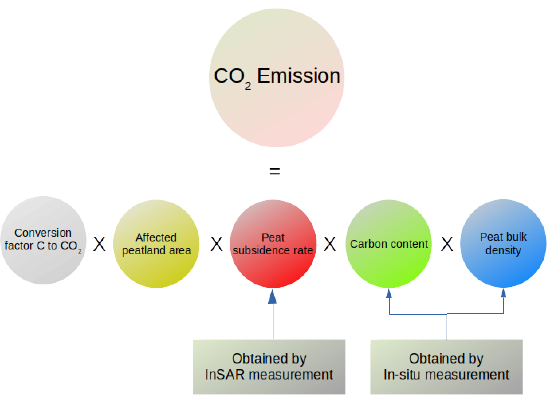
Figure 2. An illustration of parameters needed to estimate CO 2 emission based on InSAR and In-situ surveying data.